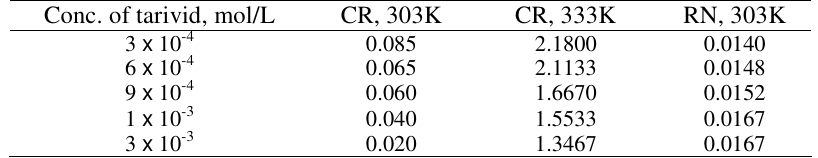
Table 2. Corrosion rate (cm 3 /minute) and reaction number ( ° C/minute) for the corrosion of mild steel in 2.5 M H SO containing various concentrations of tarivid 2 4 Conc. of tarivid, mol/L